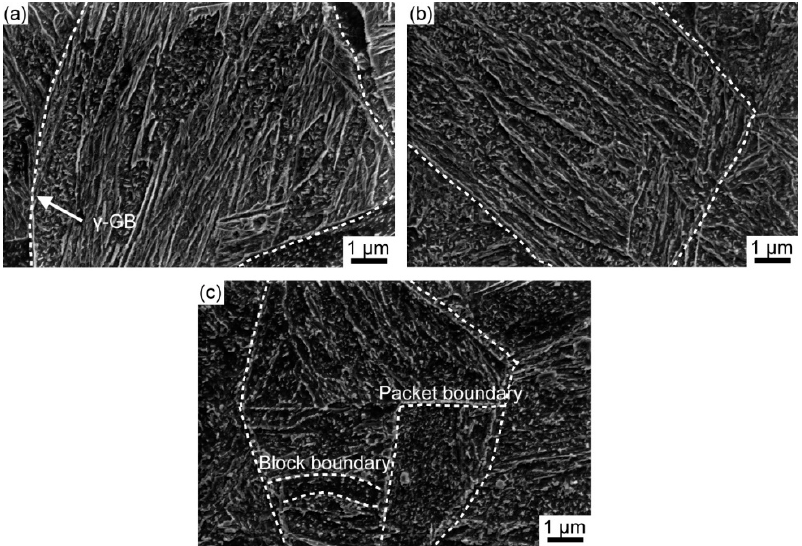
Figure 15. The metallographic change of the SCHAZ with di ff erent degrees of softening ( a ) BM at 6.0